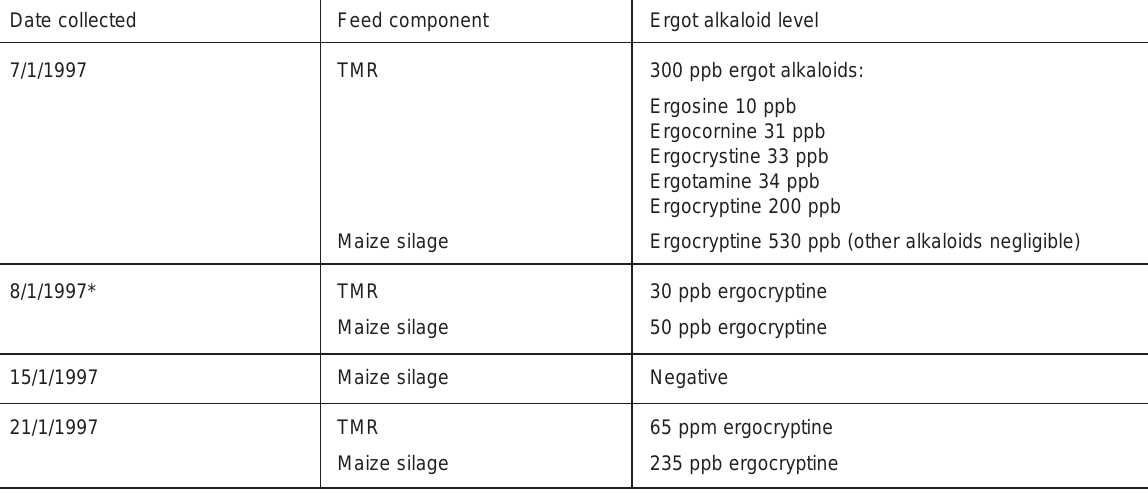
TABLE 1 Results of chemical analyses of different batches of maize silage and TMR Date collected